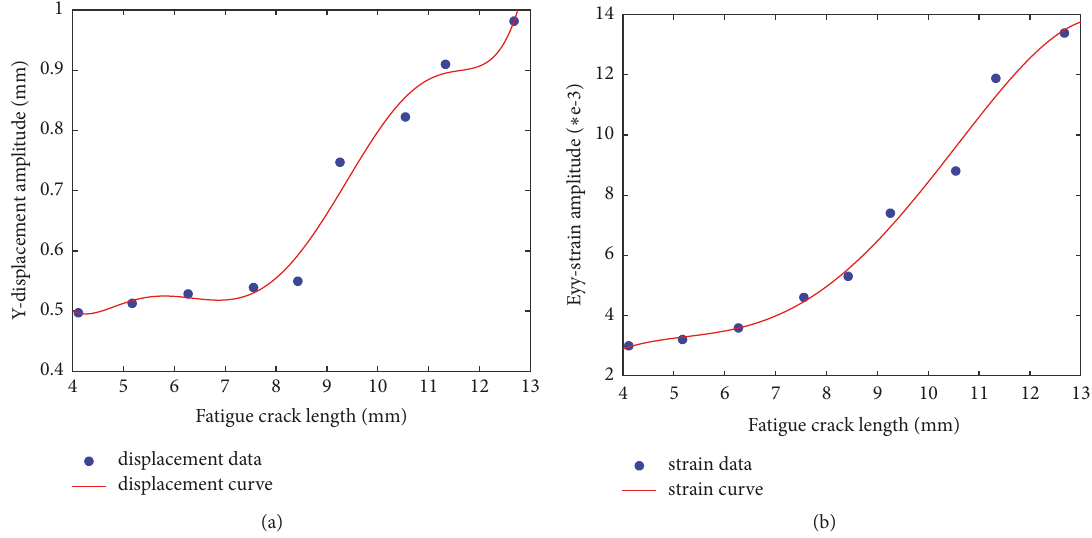
Figure 22: (a) Relationship between crack length and Y-direction displacement amplitude of feature point. (b) Relationship between crack length and Y-direction strain amplitude of feature